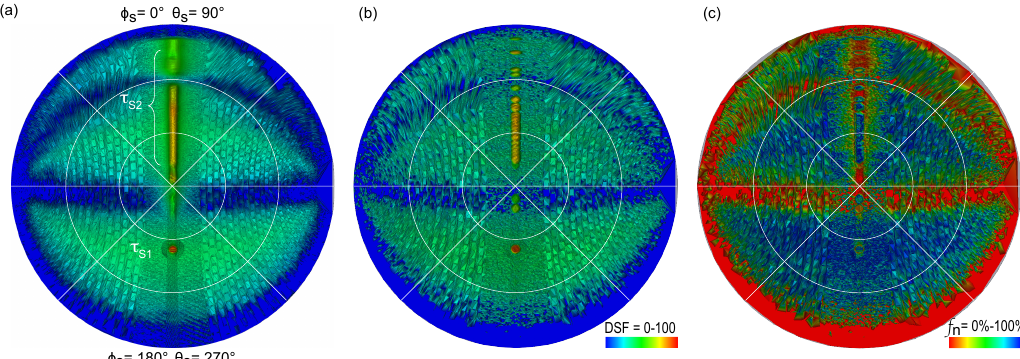
Figure 10. DSF (logarithmic) for φ i = 0 ◦ and θ i = 35 ◦ in the transmission hemisphere: ( a ) The measurement V1 and ( b ) the simulation V3 show prominent features such as the directly transmitted ( τ ω ) or the redirected light ( τ S ) in the same topology. The diffuse background has a similar form but is obscured by noise in the simulation. The measurement shows a continuous ridge along φ i = 0 ◦ while in the simulation tessellation is manifested in discrete peaks; ( c ) This leads to areas of lower local accordance ( f j , A , B ) along the ridge. The lowest local accordance is reached for very low DSF where the simulation is affected by noise.